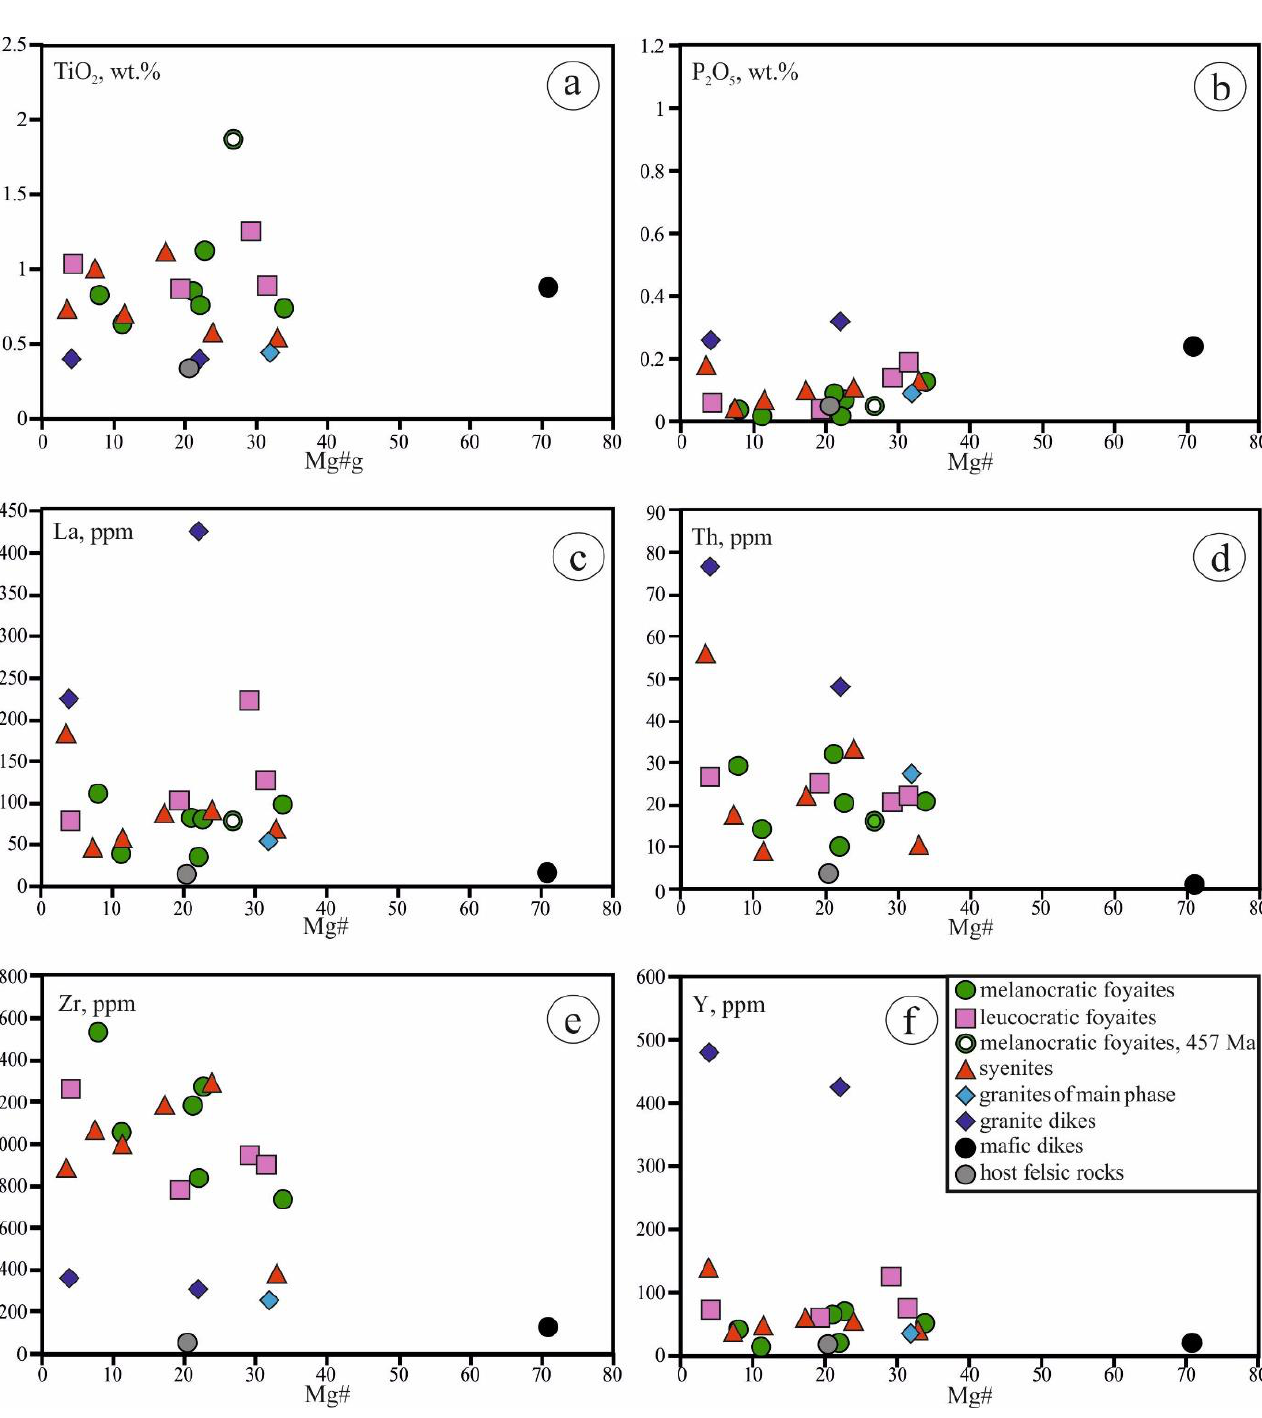
Figure 8. ( а – f ) Variations of TiO 2 , P 2 O 5 , La, Th, Zr, and Y vs. Mg# for the Saibar rocks. Mg# = Mg × 100/(Mg + Fe 2+ ), where Mg = MgO/40.31, Fe 2+ = (Fe 2 O 3 * × 0.8998 × 0.85)/71.85. All samples show different enrichment in K 2 O content and Na 2 O/K 2 O ratios (Figure The rocks comprising the main volume of the intrusion exhibited high total Fe, calcu- 7b); with a decrease in SiO 2 content among all Saibar rocks, the composition points shift lated as Fe 2 O 3 , and low MgO contents; the Mg# value varies in foyaites from 4 to 34 and from shoshonitic to calc–alkaline composition field. The modified alkali–lime index in syenites from 3.5 to 24, and in granite Mg# corresponds to 32. In dyke granites Mg# (MALI) obtained from the Na 2 O + K 2 O − CaO vs. SiO 2 plot (Figure 7c) is strongly alkaline varies from 4 to 22 (Table 2). These variations indicate a high degree of fractionation of for foyaites and syenites and is associated with the enrichment by albite and alkali feld- the initial magmas and practically do not affect the change in the concentrations of both spar. The composition point of the mafic dyke is plotted in the calc–alkaline field. major components (SiO 2 , P 2 O 5 , TiO 2 ) and trace elements (La, Th, Zr, and Y; Figure 8a–f). Foyaite samples have metaluminous (A/CNK = 0.69–0.95) values. Compared to foy- Compared to these granites, foyaites and syenites have the highest TiO 2 (0.6–1.3 aites, syenites and granites are intermediate in composition between oversaturated alkalis and peraluminous ones (A/CNK in syenites = 0.95–1.29, A/CNK in granites = 0.88–1.05;